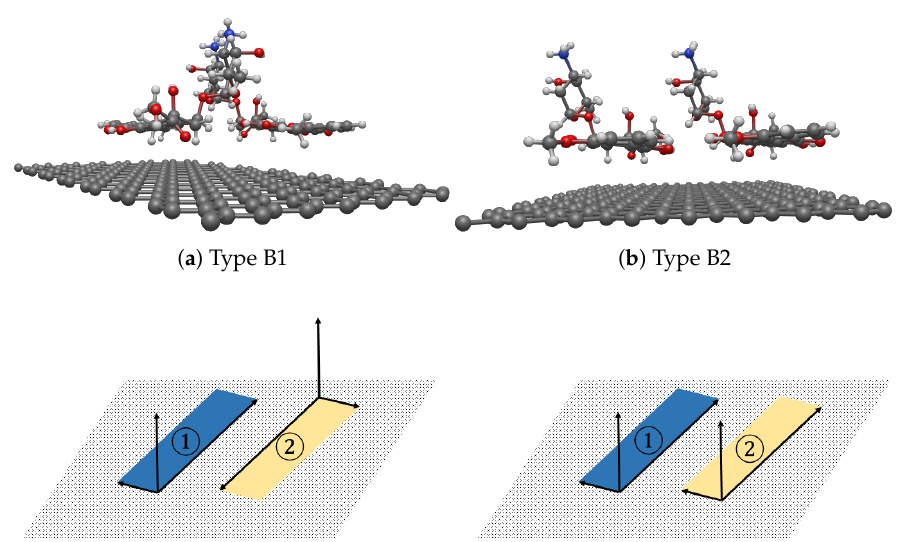
Figure 7. Two stable configurations (first row) and their vector representations (second row) of ( a ) seed III-9 for Type B1 and ( b ) seed III-8 for Type B2 for the interaction between two DOXHs and graphene where 1 (cid:13) and 2 (cid:13) indicate two carbon planes.